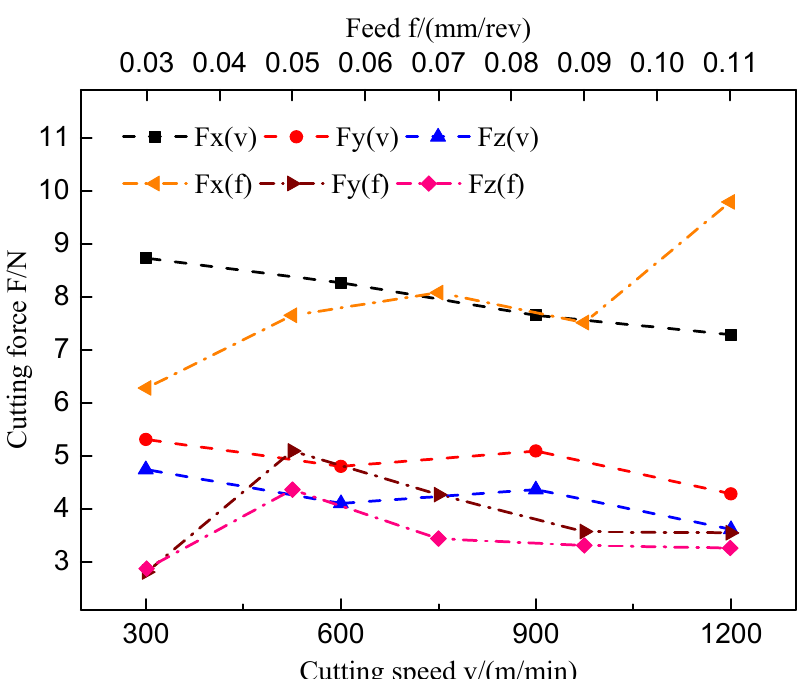
Figure 2. The variation of cutting force by the cutting parameters(The feed is 0.05 mm/rev, cutting depth is 0.5 mm and cutting width is 3 mm when the cutting speed changes; The cutting speed is 900 m/min, cutting depth is 0.5 mm and cutting width is 3 mm when the feed changes).